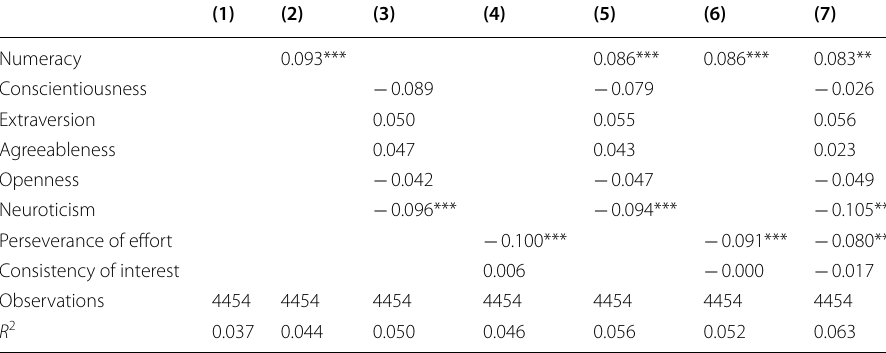
Table 7 Social trust and cognitive and non-cognitive skills